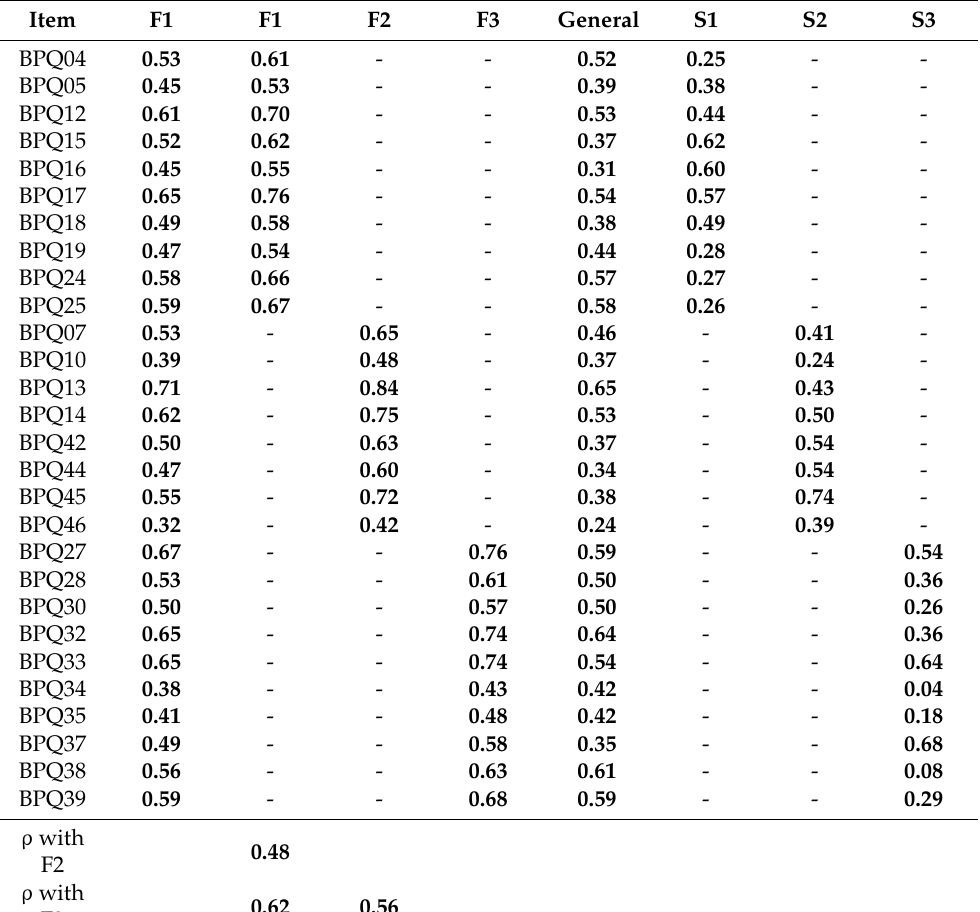
Table 5. Parameter estimates of the one-factor (left), of the three-correlated-factor model (center), and of the bifactor model (right) (data from the second random subsample, n = 693). Item